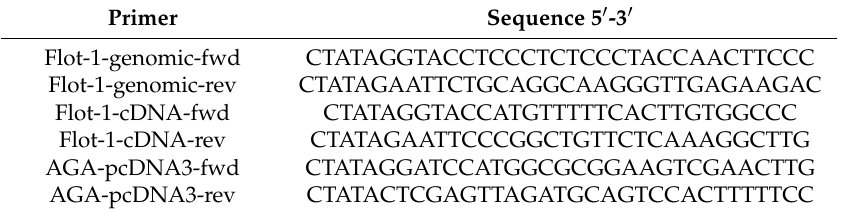
Table 2. Sequences of the primers used for cloning of the genomic or cDNA fragments into a plasmid for